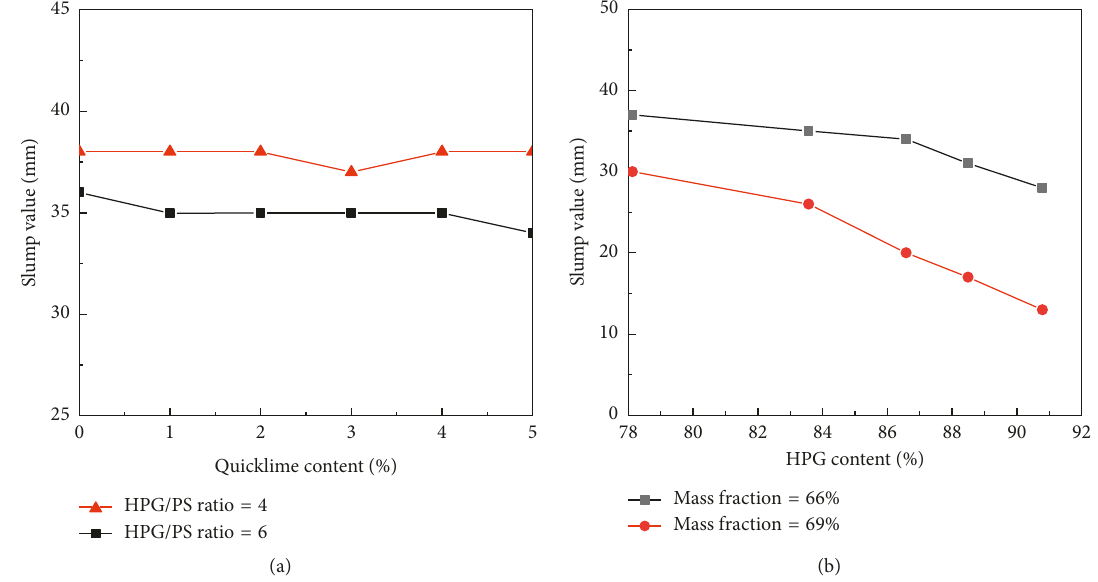
Figure 5: Effects of quicklime content and HPG content on the slump value of backfill slurry. (a) Mass fraction of 66%; (b) cement content of